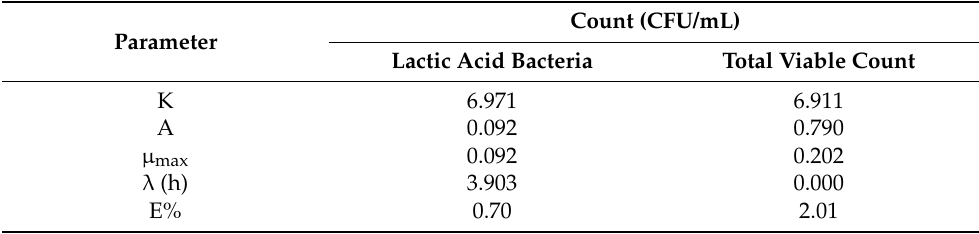
Table 3. Gompertz parameters for total viable and lactic acid bacteria population during millet slurry fermentation. Count (CFU/mL) Parameter Lactic Acid Bacteria Total Viable Count